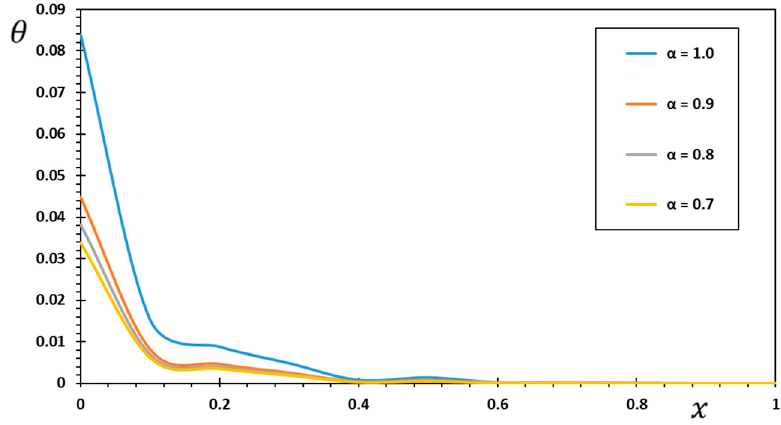
Figure 3. Effect of fractional order, α , on the temperature, θ .